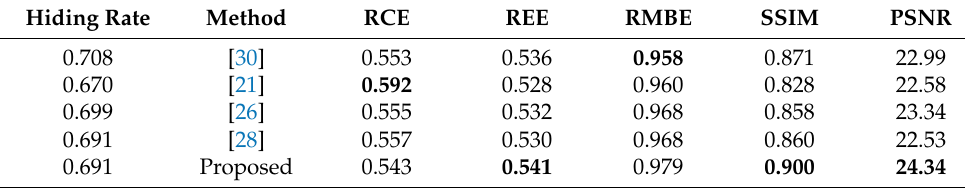
Table 8. Average metrics using the images of Figure 15 and F , C =